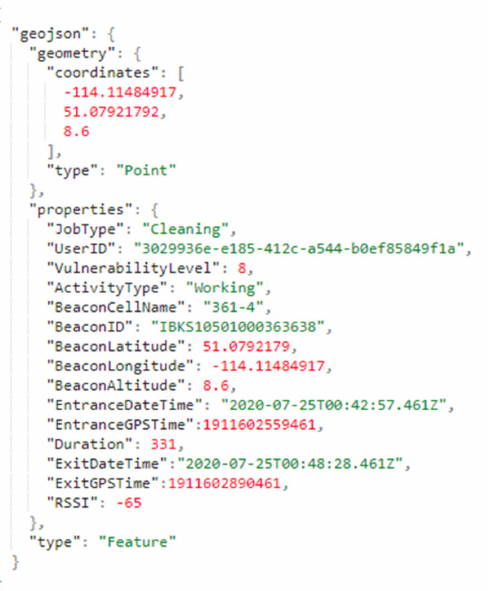
Figure A3. A single JavaScript Object Notation (JSON) payload showing the Place of Stay (POS) record of one of the users received in the Amazon Web Services (AWS) IoT